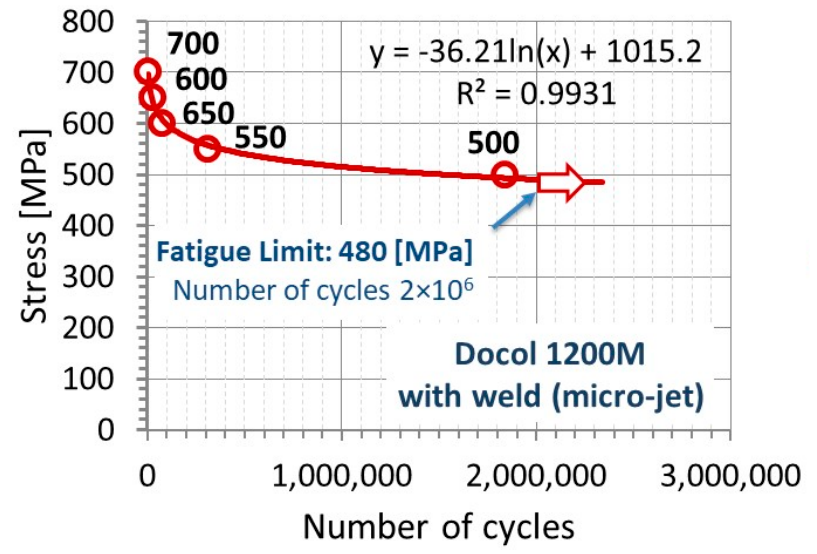
Figure 13. The Wöhler curve of the weld with micro-jet cooling technology on the Docol 1200 M steel. The obtained results show